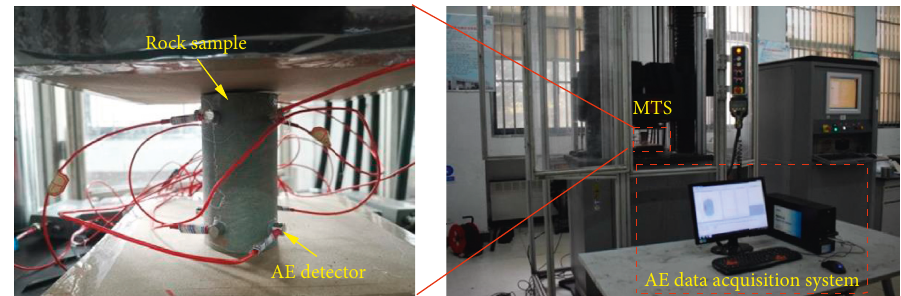
Figure 1: Cyclic loading and unloading